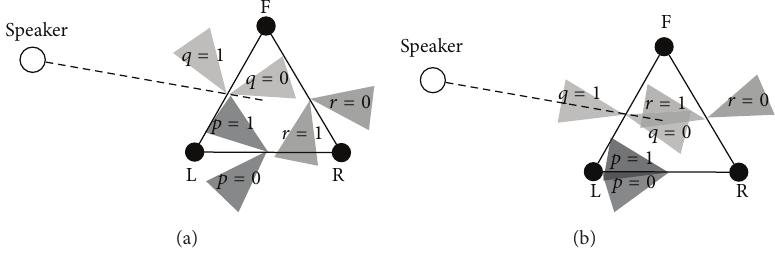
Figure 5: (a) Incoherent set of measures. (b) Coherent set of measures (taken from [5]).